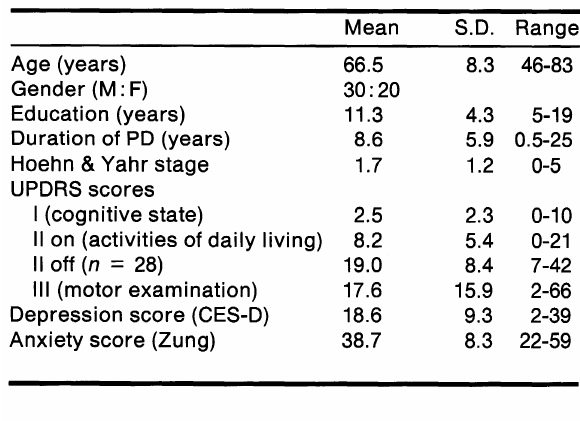
TABLE I. Characteristics of the patients